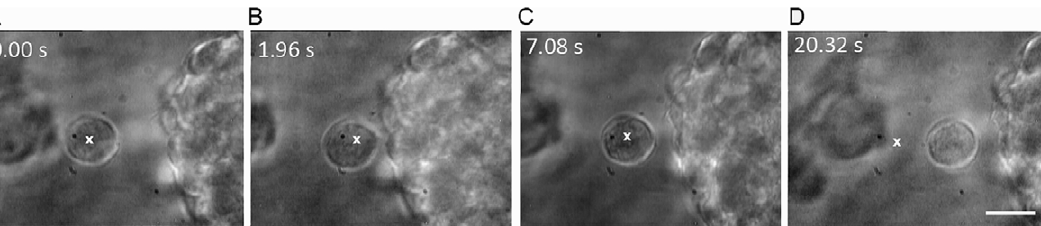
Figure 6. Time-lapse images of filopodia-mediated cell adhesion dynamics. A) – D) Time lapse images from a real-time movie (Movie S3) showing adhesion of a neural progenitor cell to a neurosphere via filopodial interaction. The white cross denotes the position of the optically-trapped cell being brought towards the neurosphere. The single cell adheres to the neurosphere after approximately 5 seconds. Note the faintly visible filopodial bridge connecting the neural progenitor to the neurosphere in panel C). The scale bar denotes 10 m m.